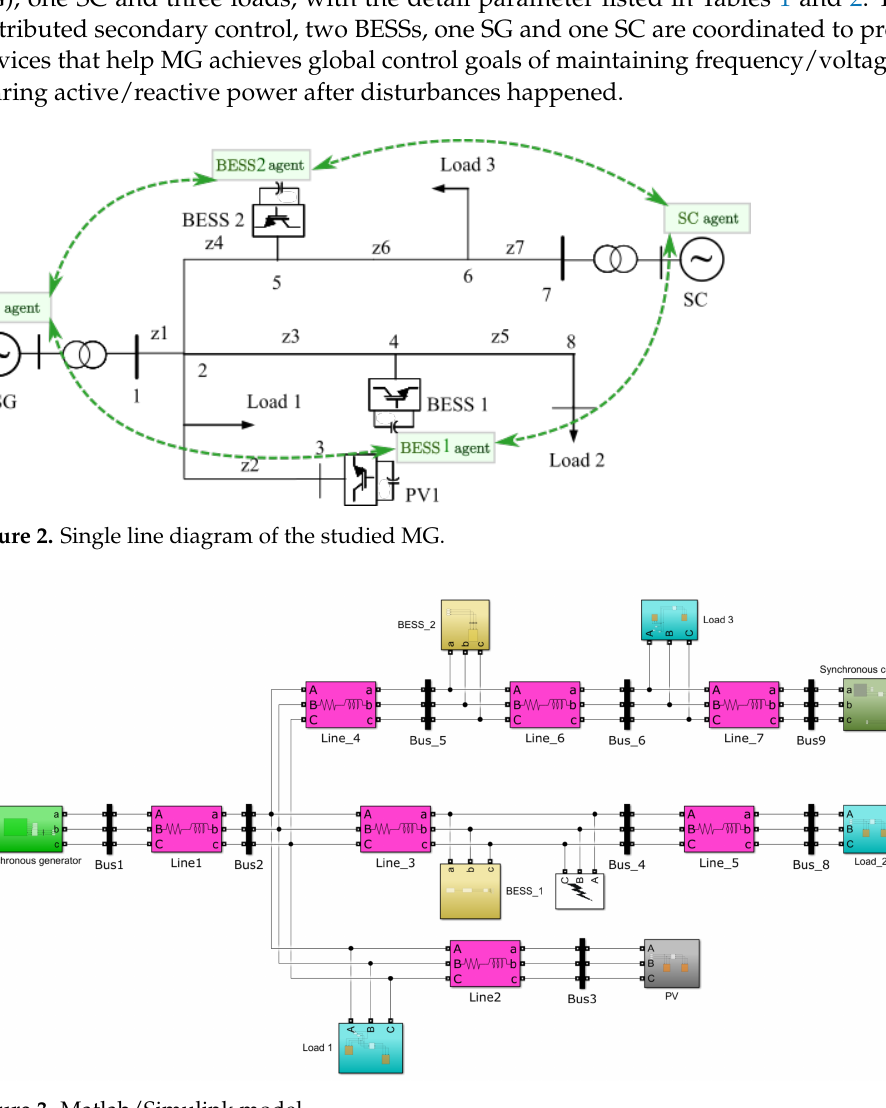
Figure 3. Matlab/Simulink